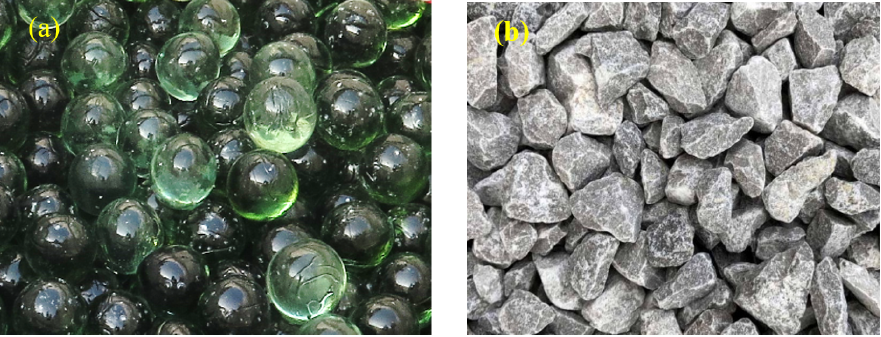
Fig. 1. Coarse aggregates used in this study